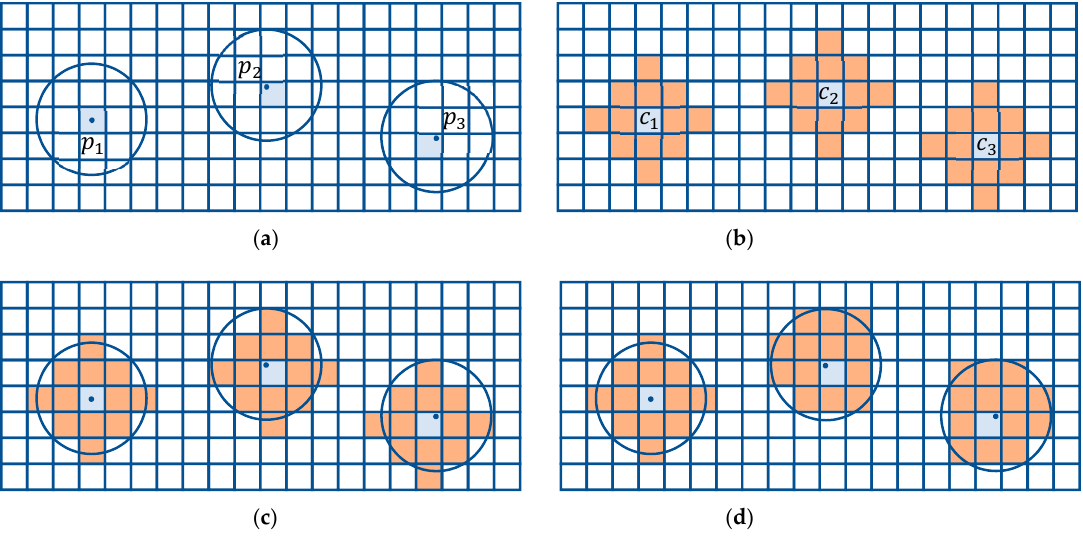
Figure 7. ( a ) A series of points (quantized cells are shown in light blue) representing locations of a mobile IoT device and corresponding o ff set regions. ( b ) O ff set cells centred on c 1 and subsequently determined o ff set cells centred on c 2 and c 3 . ( c ) O ff set cells centred on c 2 and c 3 may have discrepancies. ( d ) O ff set cells centred on each point.